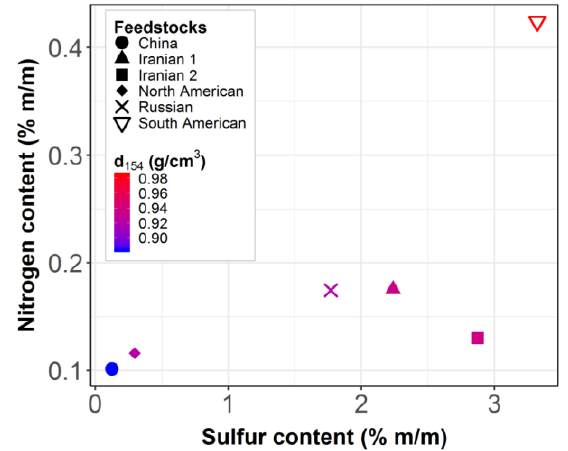
Figure 10. Liquid e ffl uent nitrogen as a function of time on stream (same feedstock, P = 140 bar). Figure 10. Liquid effluent nitrogen as a function of time on stream (same feedstock, P = 140 bar).